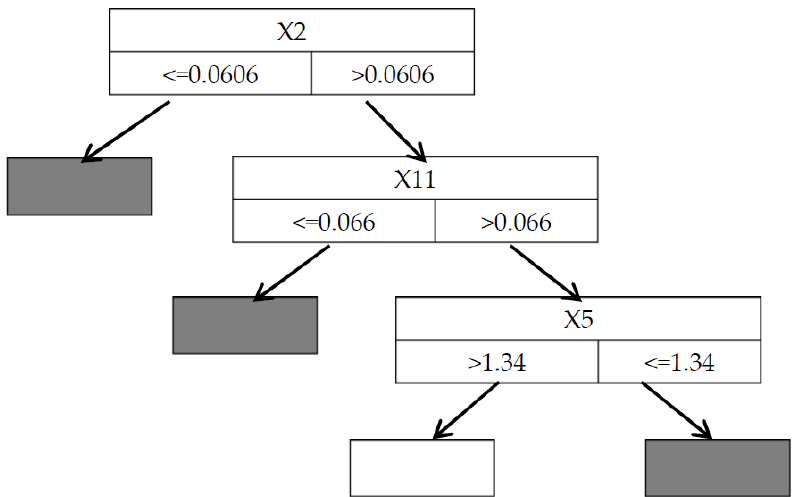
Figure 4. The structure of the Classification and Regression Tree (C&RT) model for Central European households. Gray box indicates consumers at risk of insolvency. White box, consumers at high financial health. Source: based on own studies.